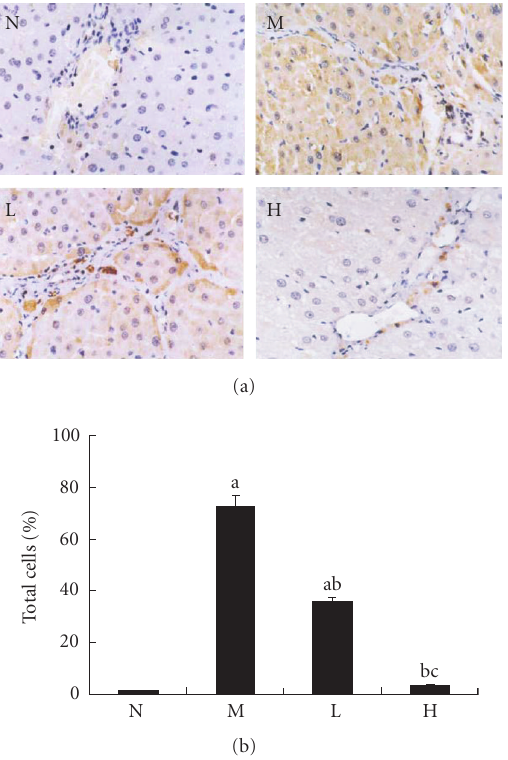
Figure 6: Immunohistochemical staining for VCAM-1 in rat liver. N represented the normal control group; M represented the model group; L represented the group treated with low dose of thalido- mide; H represented the group treated with high dose of thalido- mide. (a) Positive VCAM-1 cells were mainly distributed at the fi- brosepta band, area of necrosis, and inflammatory cell infiltration in hepatic lobules (M, L, and H) (original magnification N, M, L, H, × 400, immunohistochemical staining). (b) Comparison of the ex- pression of VCAM-1 using immunohistochemical analysis. a P < . 01 versus normal control group; b P < . 01 versus model group; c P < . 01 group treated with high dose of thalidomide versus group treated with low dose of